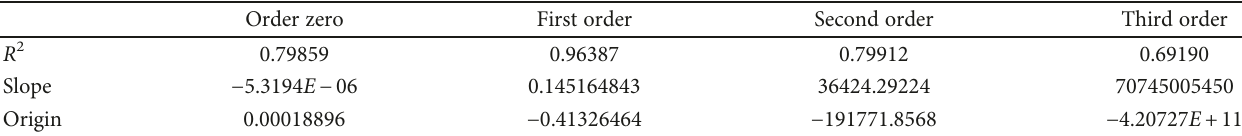
Table 9: Determination of the degradation reaction order of ketorolac with ultraviolet radiation.